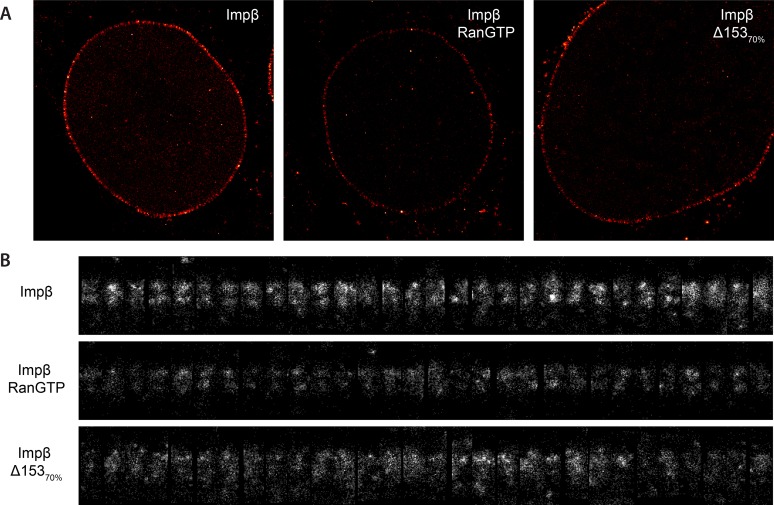
Examples of raw localization data for each of the conditions.(A) Total raw localizations for each of the conditions presented in Figure 3. Note the strongly reduced number of localizations in the Ran+GTP case. Each image is plotted on the same intensity scale. (B) 30 randomly selected examples of individual putative NPC structures identified from each of the data sets presented in (A) and rotated and aligned to a common frame. The data are presented unnormalised but plotted on a common intensity scale. Again, note the strongly reduced number of localizations in the Ran+GTP and ∆Nup153 case. Also note the increased heterogeneity amongst the structures in the knockdown data.